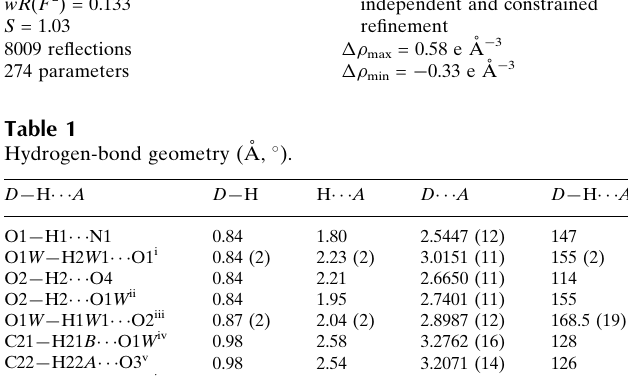
Data collection Bruker SMART APEXII CCD area-detector diffractometer